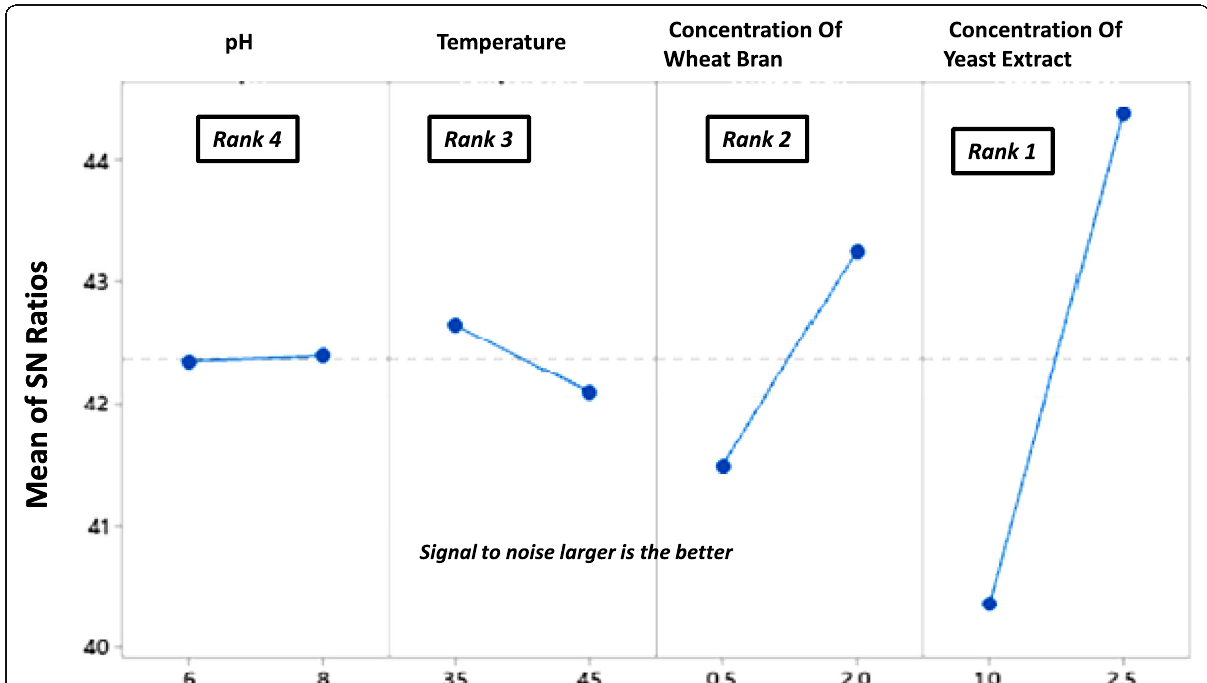
Fig. 5 Signal-to-noise ratio computed for each